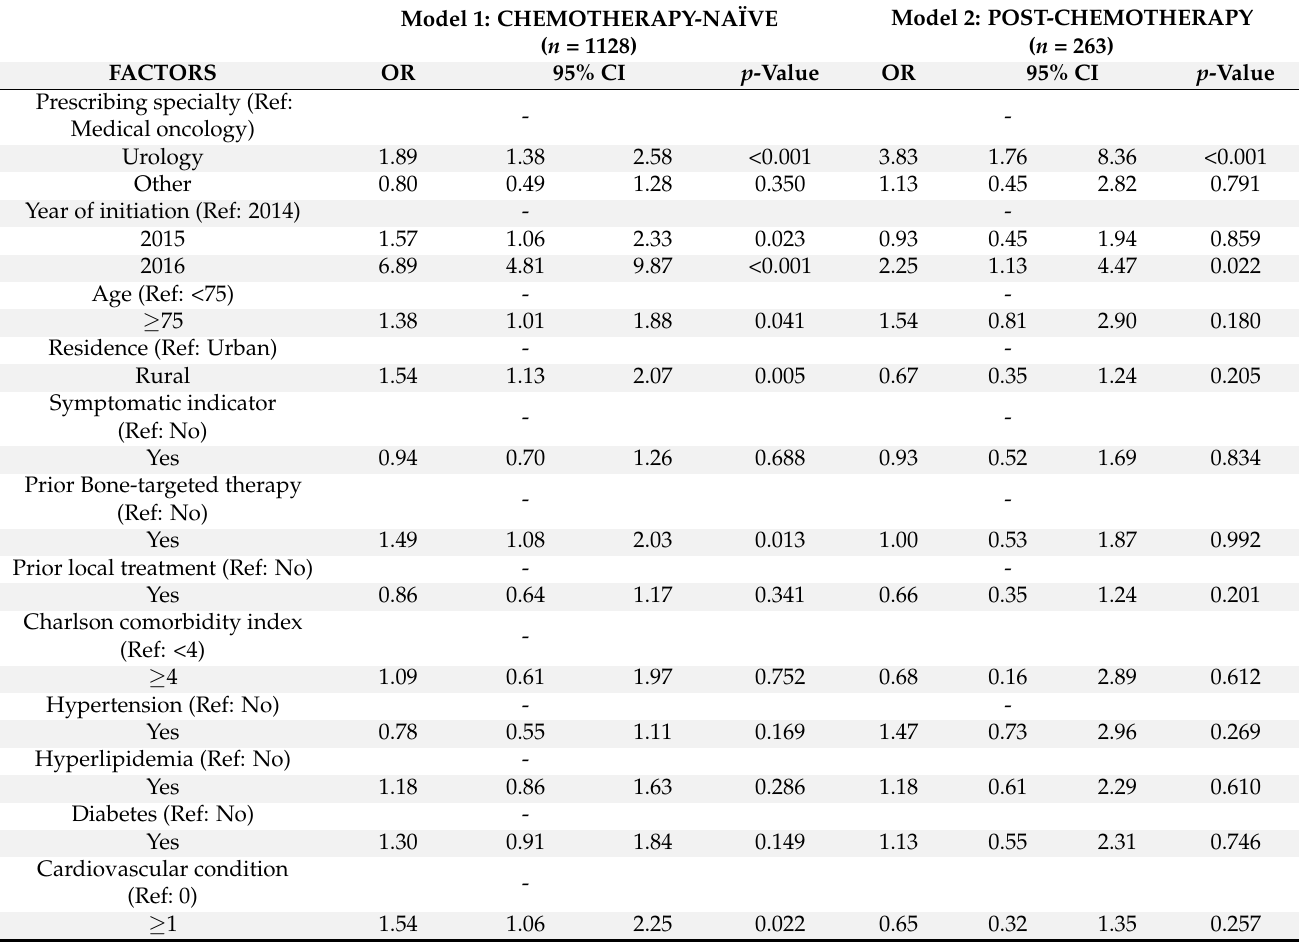
Table 2. Multivariable analysis of variables associated with receiving ENZ (over ABI) in ENZ-era. Model 2: Model 1: CHEMOTHERAPY-NAÏVE ( n = 1128)